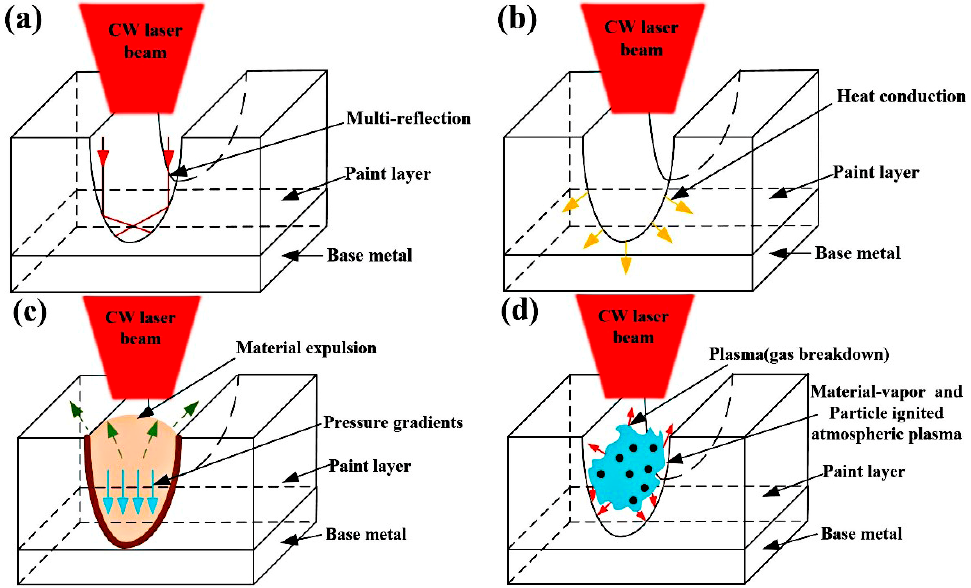
Figure 6. Schematic illustration ( a – d ) of the thermal ablation mechanism for Continuous wave (CW) laser cleaning.